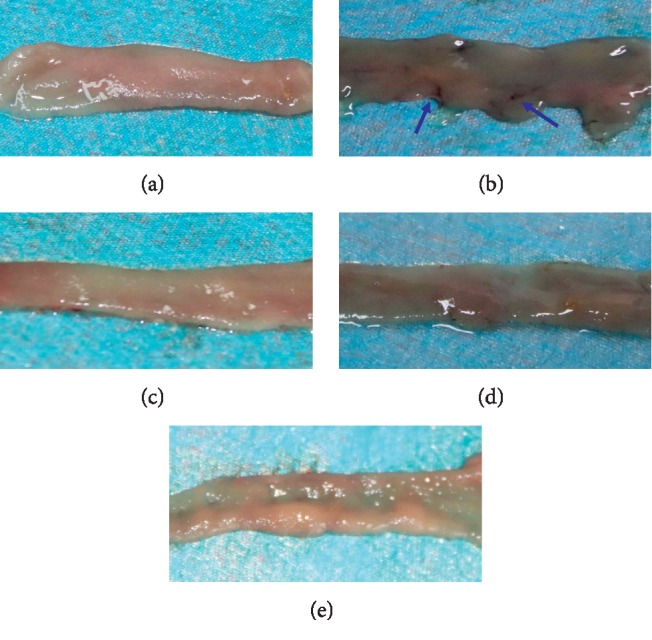
Effect of LZD on the severity of duodenal lesion examined in IND-induced duodenal ulcer model in rats. Blue arrows indicate lesions. (a) Normal Control. (b) Negative control (IND). (c) ESO (4.17 mg/kg). (d) LZD (3.75 g/kg). (e) LZD (7.50 g/kg).